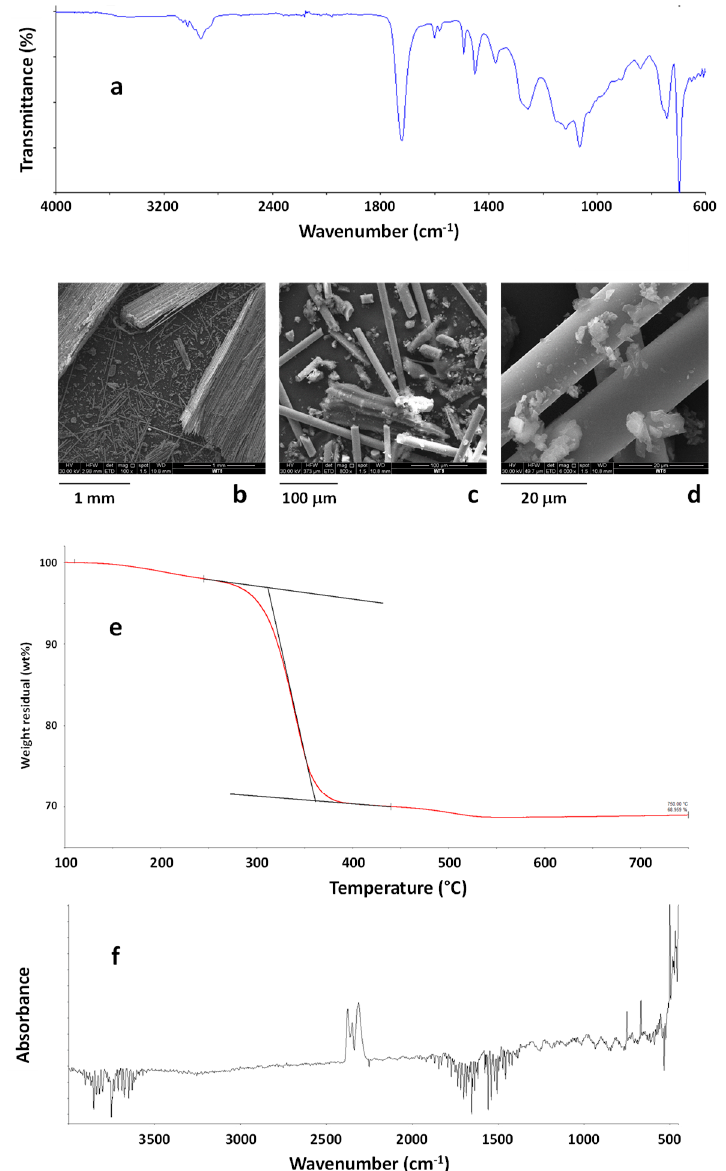
Figure 9. ATR-FTIR spectrum of wind turbine blade (WTB) waste ( a ). SEM images of WTB waste ( b, c, d ). TG curves of the WTB sample in the temperature range 100–750 °C ( e ). FTIR spectra of evolved gases from WTB waste at 280 °C under air flow ( f ).